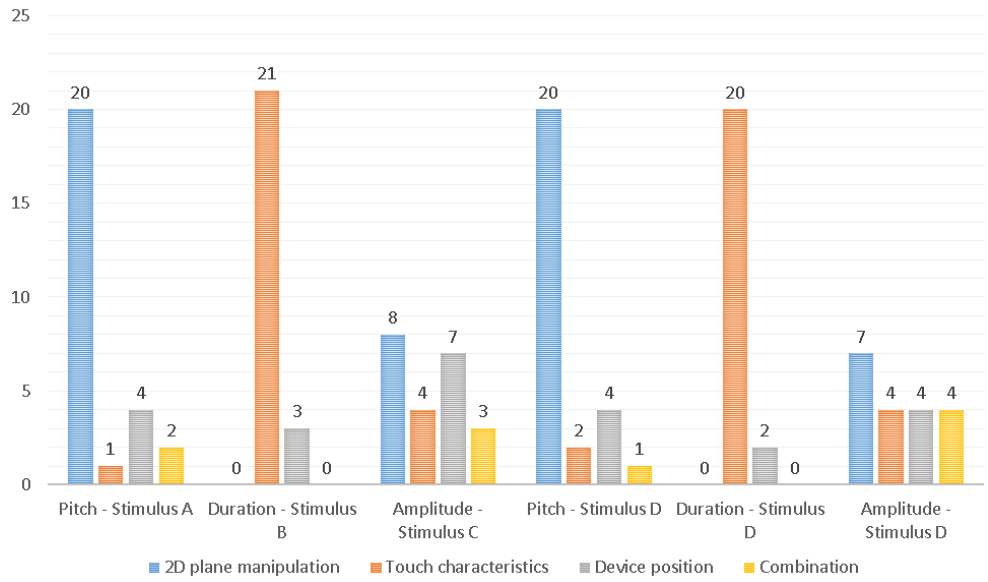
Figure 12. Frequency of participant (musician and non-musician) gesture choice in phase 2—categorized